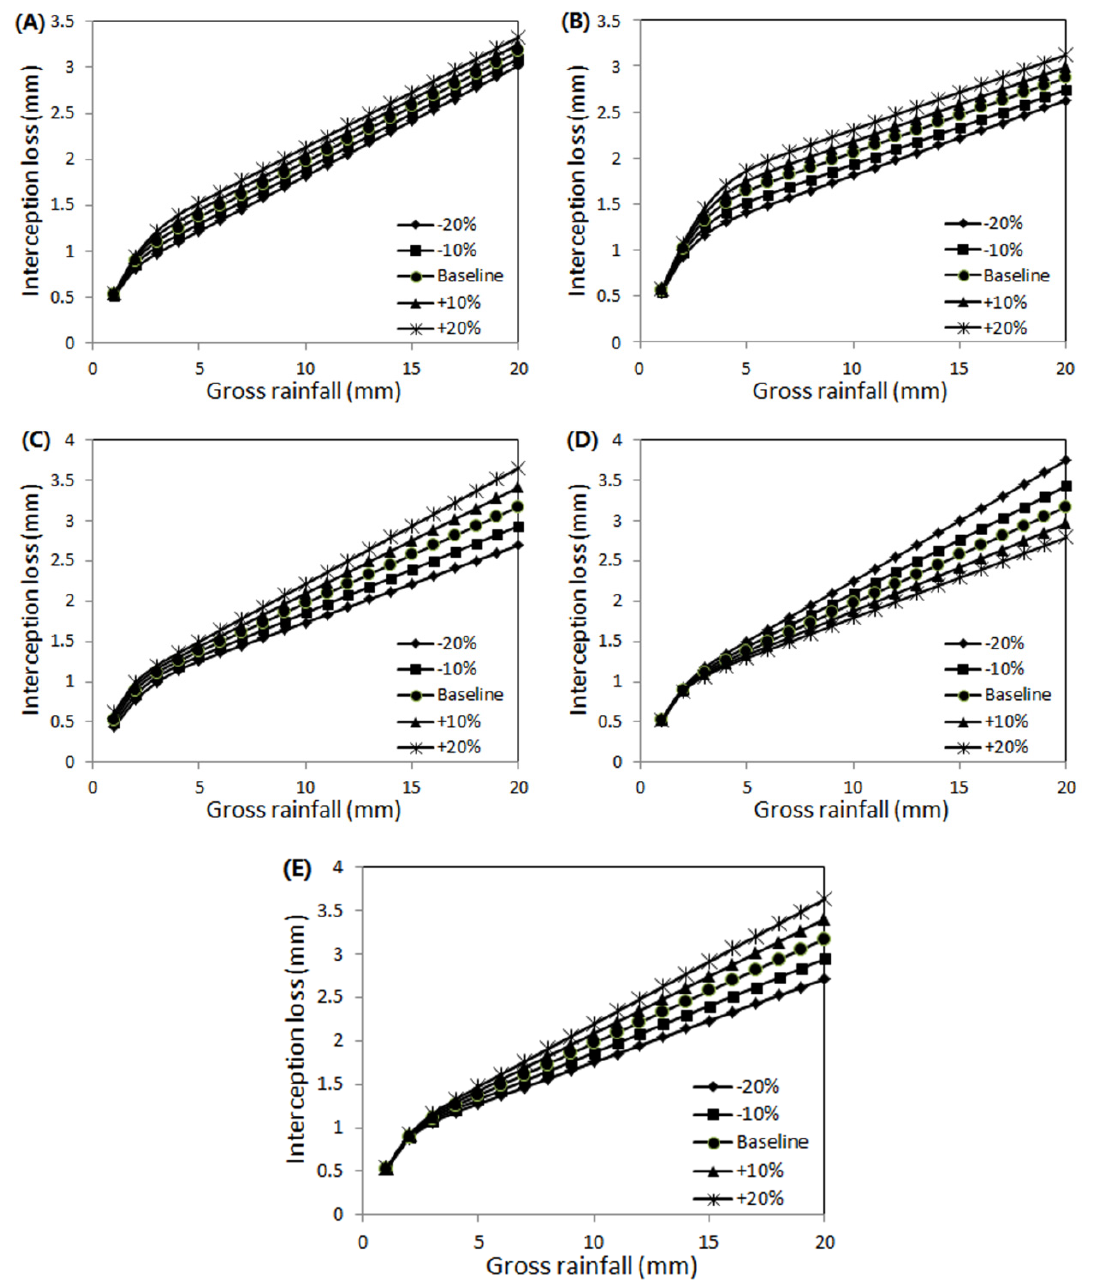
; ( B ) VAI; ( C ) FVC; ( D V